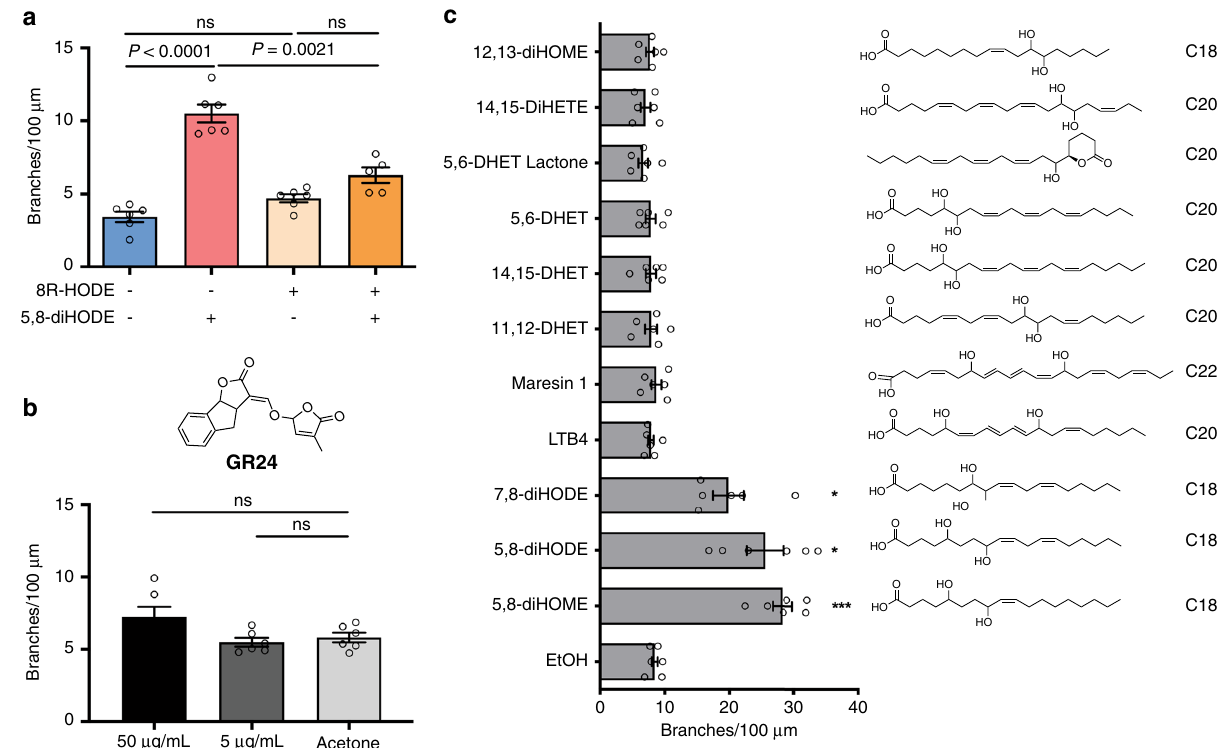
Fig. 3 Hyperbranching is induced by speci fi c diol oxylipins. a Hyphal-branching analysis of Af293 WT when 8R-HODE (5 µ g/mL) alone, 5,8-diHODE (5 µ g/mL) alone, and 8R-HODE and 5,8-diHOE (both at 5 µ g/mL) were treated to spores and grown for 20 h in micro fl uidic wells ( n = 6 for no oxylipin, 8R-HODE alone, 5,8-diHODE, and n = 5 for 5,8-diHODE + 8R-HODE). b Branching analysis when GR24, a synthetic strigolactone, was treated to Af293 WT at 50 or 5 µ g/mL compared to the acetone solvent control ( n = 6). c Screen of a panel of dihydroxy oxylipins on Af293 WT for hyphal branching ( n = 6). For all experiments, six hyphae were randomly selected across micro fl uidic wells and imaged every 15 min between 20 h and 25 h post inoculation. Compounds were either commercially purchased or puri fi ed in the laboratory and resuspended in EtOH. Brown – Forsythe and Welch ANOVA tests were performed, followed by Dunnett ’ s T3 multiple comparison test in between each group in ( a ), and between the solvent control and each treatment group in ( b , c ). All values represent mean ± SEM. P values corresponding to asterisks from top to bottom in ( c ) are: 0.0372, 0.0146, 0.0001. ns not signi fi cant ( P > 0.05).